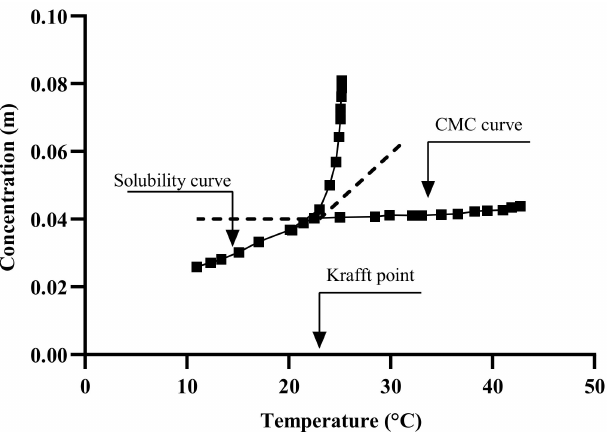
Figure 13. Conceptual chart of the Krafft point and CMC adapted from